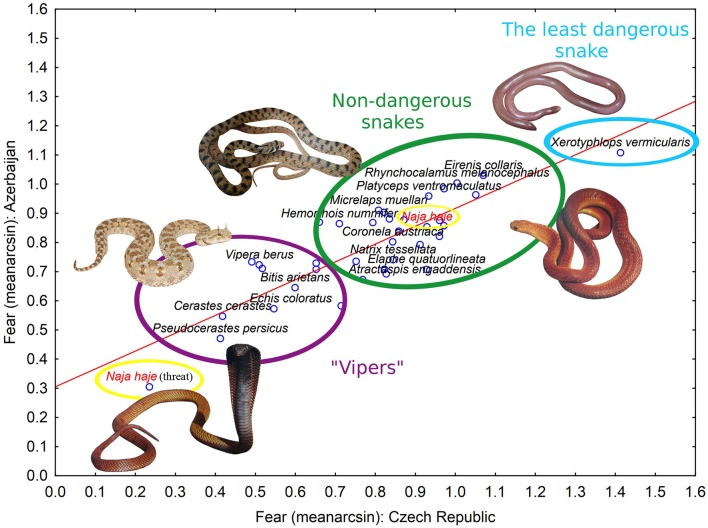
A correlation of fear evaluations from the Czech Republic and Azerbaijan. The graph was calculated from square-root arcsin-transformed data, i.e., the lower the value the more fearful the species is according to the respondents (Pearson correlation coefficient; r2 = 0.683, p < 0.0001). The highlighted evaluation of the Egyptian cobra in two positions illustrates different perception of snakes depending on their posture.